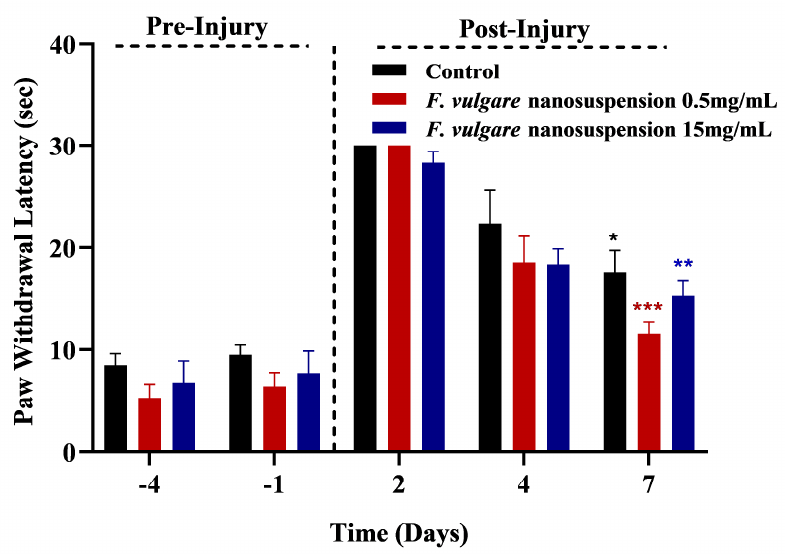
Figure 4. Effects of F. vulgare on recovery of sensory function following sciatic nerve lesion. *, **, *** represents the significance of results/data.